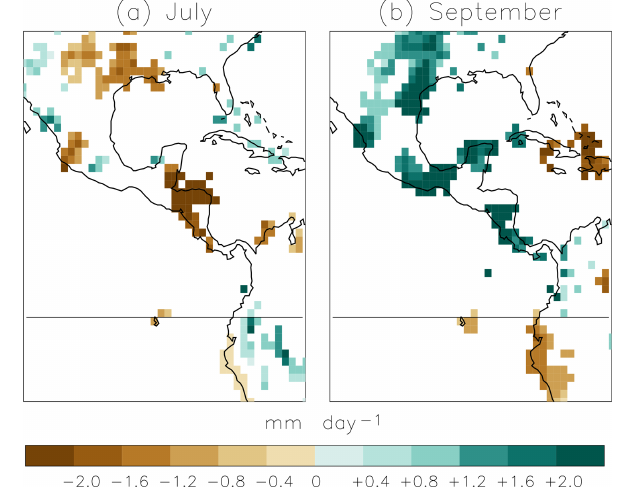
Figure 10. GPCC precipitation differences between the 11-year pe- riod 1965–1975 and 1901–1911 for (a) July and (b) September. Only differences at p < 0 . 05 are displayed.